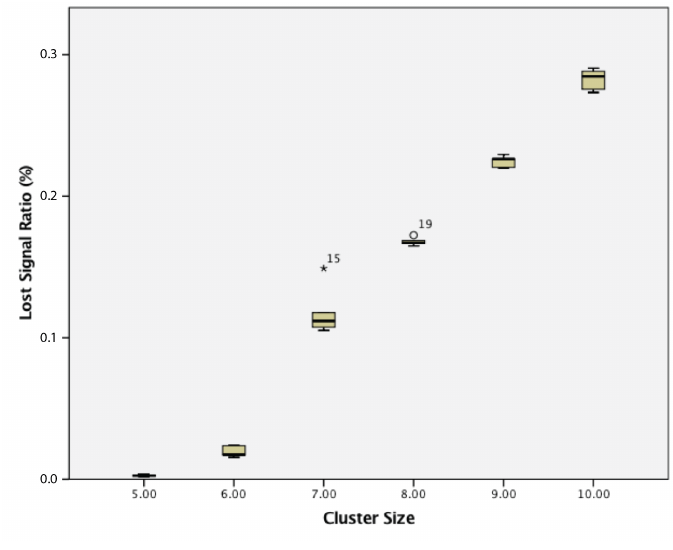
Figure 14. Lost signal ratio for clusters of 5–10 passive wireless sensor nodes with a 10 s transmission interval.